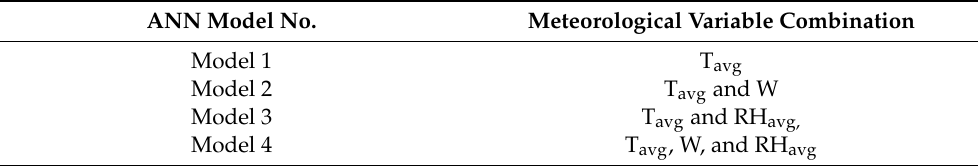
Table 2. Di ff erent meteorological variable combinations used to construct ANN